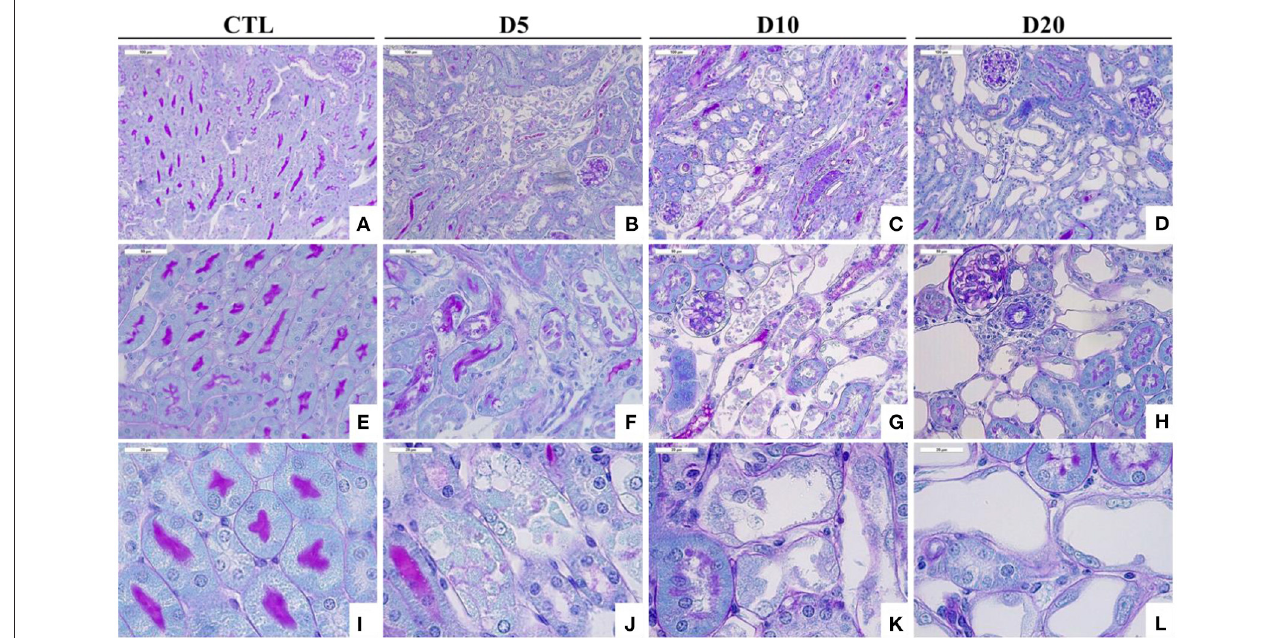
FIGURE 2 | Time course of histological alterations in experimental AAN. Representative photographs of hemalun, Luxol fast blue and Periodic Acid Schiff stained kidney sections [x200 (A–D) , x400 (E–H) , and x1000 (I–L) ] from CTL mice and mice intoxicated with AA (aristolochic acid I, Sigma-Aldrich, St. Louis, MO, USA) during 4 consecutive days. Mice were sacrificed 5, 10, and 20 days after first day of AA treatment. Necrotic tubules with cell debris in tubular lumen are visible in mice treated with AA at days 5 and 10 and cystic tubules are visible in mice at days 10 and